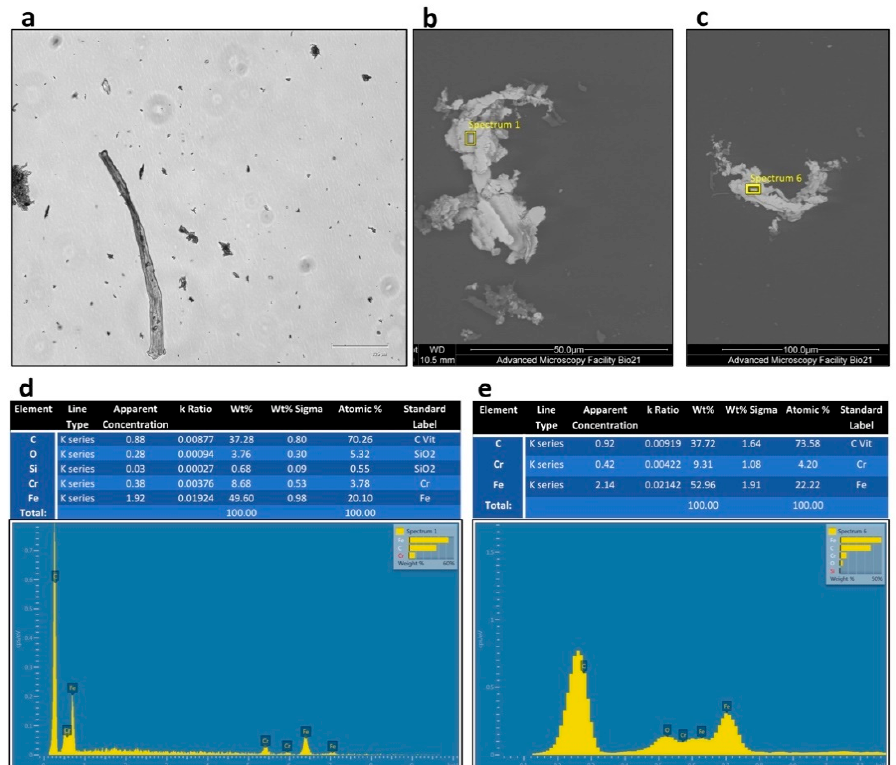
Figure 3. Aspect of the cell-free control sample (UltraPure™ distilled water alone) processed for 1 min at inverted light microscopy ( a ) and scanning electron microscopy (SEM) (FEI Tecnai F30) ( b , c ). Compositional microanalysis via electron energy-loss spectroscopy (EELS) of the debris particles identified in panel b ( d ) and c ( e ) respectively. The debris was metallic in nature with primarily iron, carbon, and chromium as its elemental composition by weight. Minute concentrations of Silica was